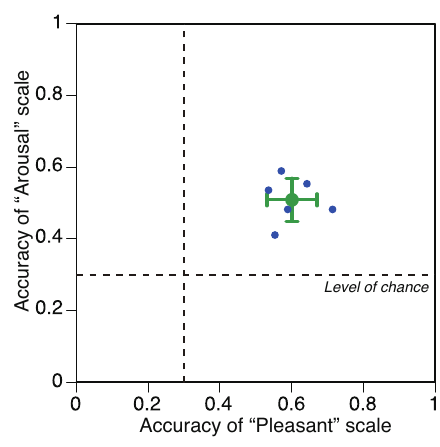
Figure 7. Prediction performance of emotional scales for “Pleasant” and “Arousal”, and their means.